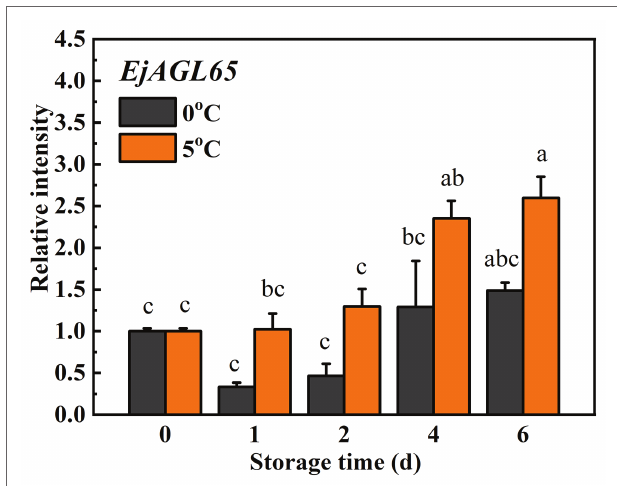
FIGURE 3 | Expression of EjAGL65 in response to temperature treatments at 0 ° C (control) and 5 ° C in “LYQ” loquat. Transcript levels of EjAGL65 before the temperature treatment were set to 1. Error bars indicate the SE of three biological replicates. One-way ANOVA followed by Tukey’s comparison was performed at p =